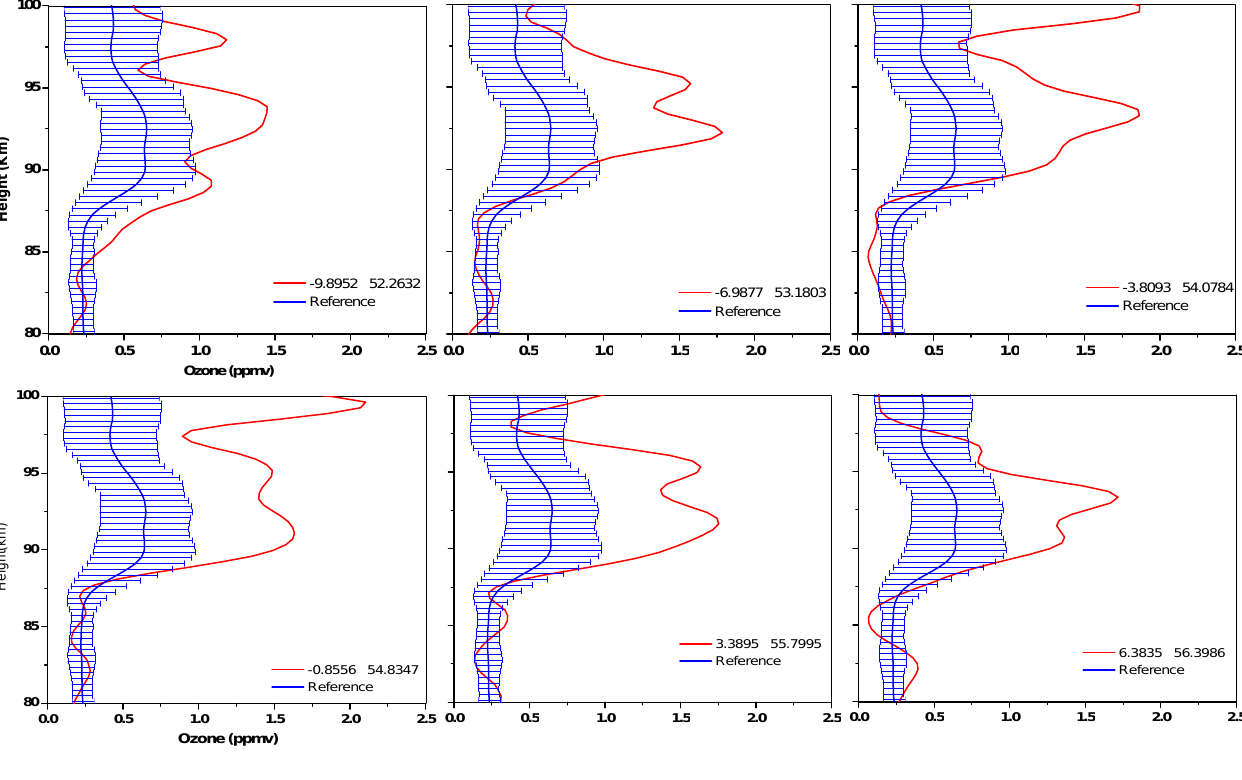
Fig. 4. Same as Fig. 2 but for MLT